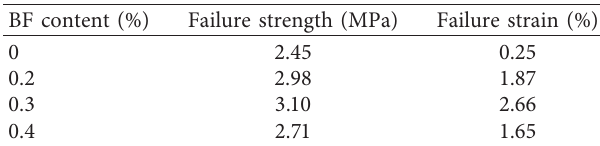
Table 7: DTT results at − 18 °